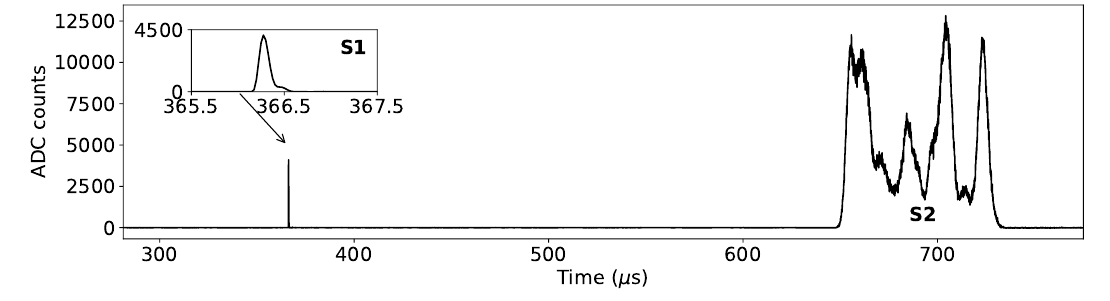
Figure 3 . The acquired waveform, summed over all PMTs, for an event in the 208 Tl photopeak. Note that this particular event was identi(cid:12)ed to contain a single continuous track, as evident partially in the existence of a single long S2